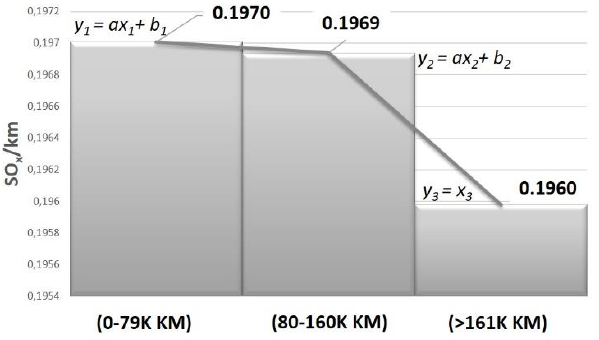
Figure 9. SO x emissions